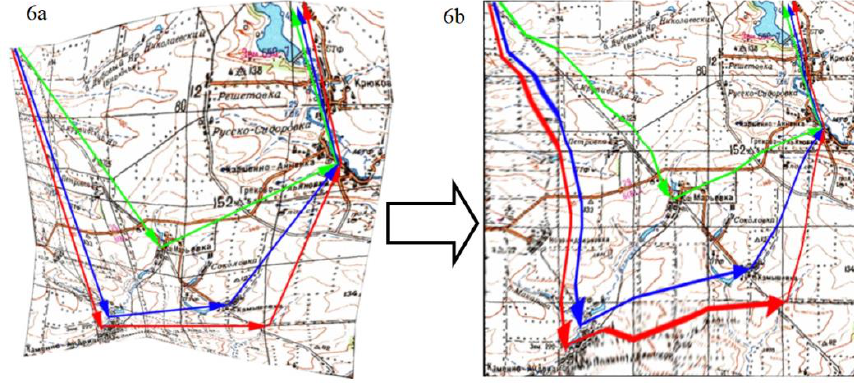
Fig. 6. Traffic routing options for transport in the linear space for the cross-country rate – 6a, in Euclidean space –